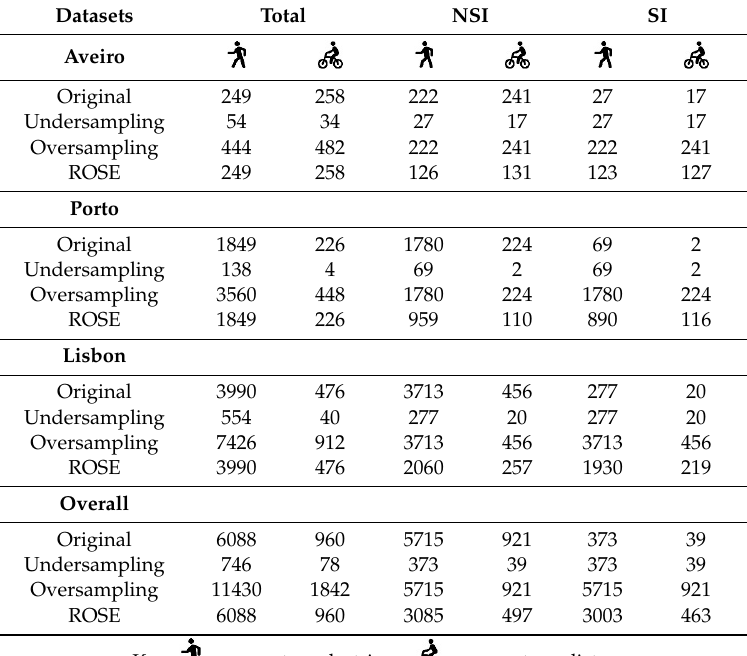
Table 2. Number of injuries and severity distribution for the different datasets. Datasets